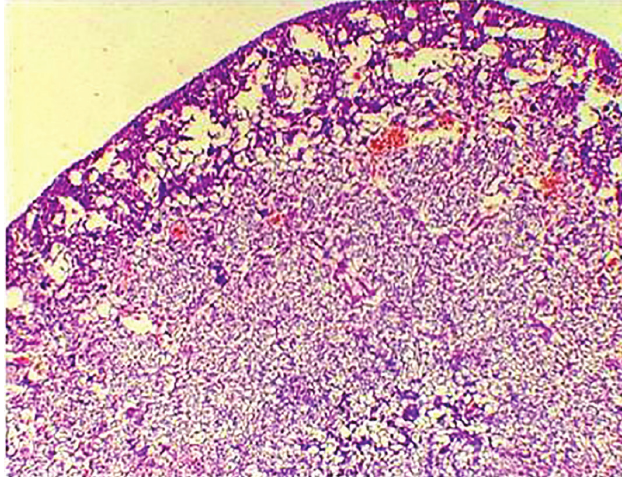
FIGURE 2(A) - Photomicrograph of section of kidney of neonate of pregnant rat (control) showing normal structure. (H & E 40X).